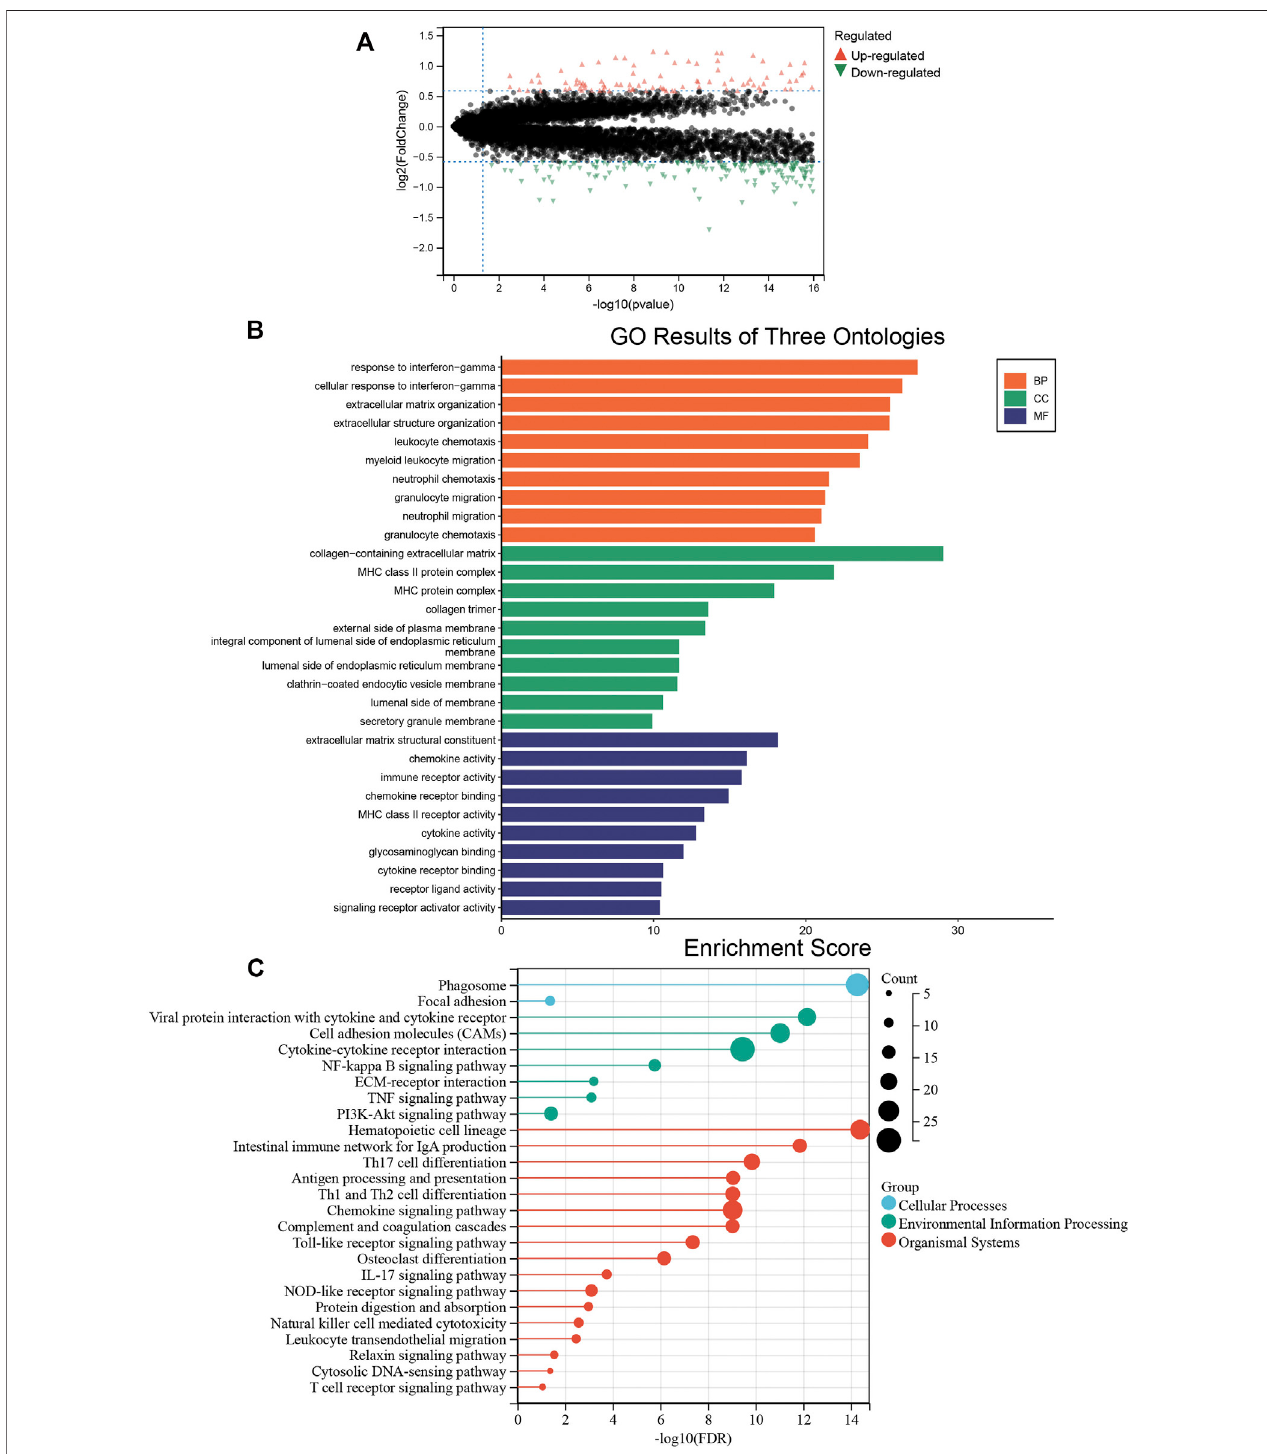
FIGURE 4 | The biological functions of differentially expressed genes between two clusters. (A) The differentially expressed genes between the Immunity_L and Immunity_H groups. Red triangles represent up-regulated genes and green triangles represent down-regulated genes. (B) Enrichment results of GO terms. Orange: biological process, green: cellular component, purple: molecular function. (C) Enrichment results of KEGG pathways. Blue: cellular process, green: environmental information processing, red: organismal systems.